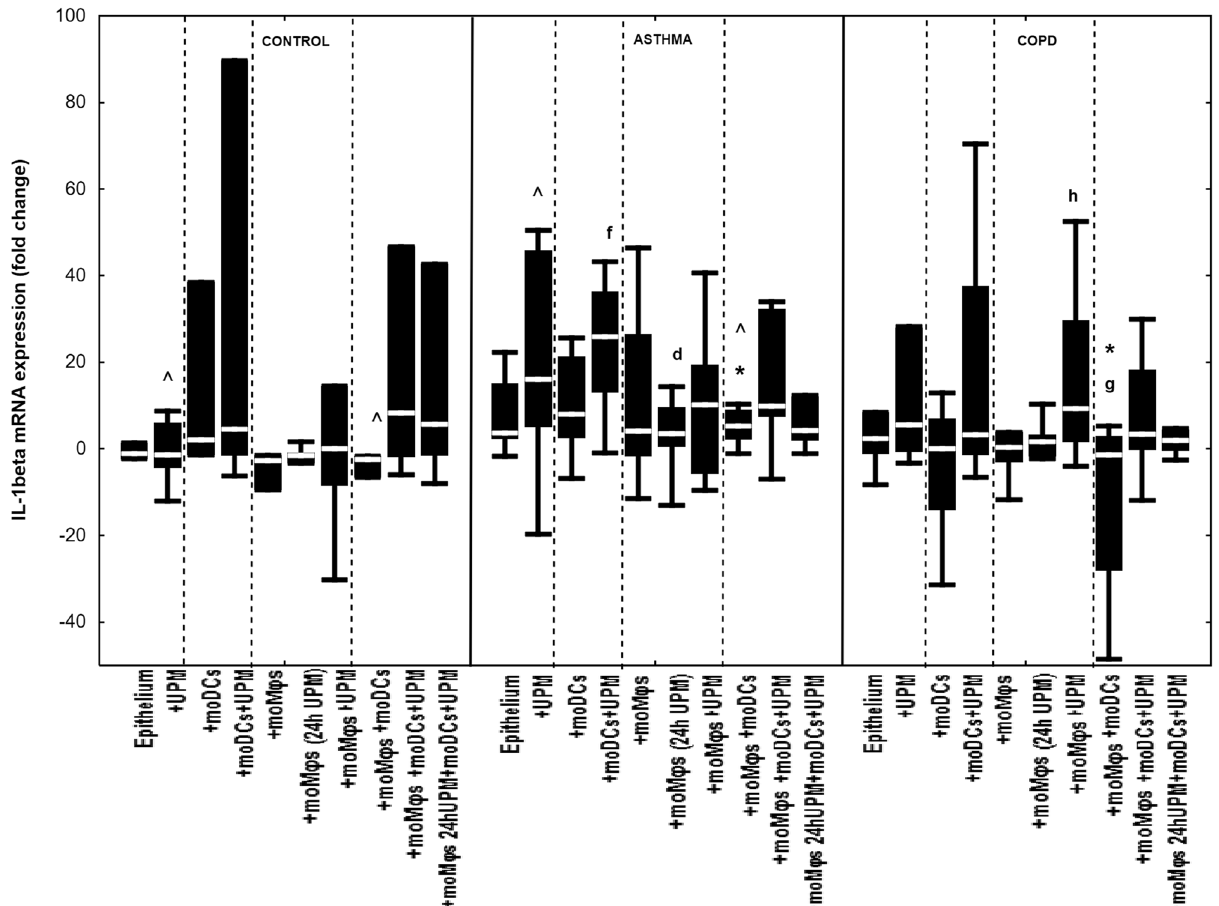
Figure 2. IL-1β mRNA expression in air–liquid interface (ALI) after 24 h UPM exposure in multi co-cultures in control subjects, asthma and COPD patients. The data are shown as non-outlier range (whiskers), interquartile range (box) and median (line); p value calculated using Mann–Whitney U test. The p value < 0.05 in comparison to: a—epithelium, b—epithelium + UPM, c—epithelium + moDCs, d—epithelium + moDCs + UPM, e—epithelium + moMφs, f—epithelium + moMφs (24 h UPM), g—epithelium + moMφs + UPM, h— epithelium + moMφs + moDCs, i—epithelium + moMφs + moDCs + UPM, j—epithelium + moMφs (24hUMP) + moDCs + UPM; ^ asthma versus control, # COPD versus control, *asthma versus